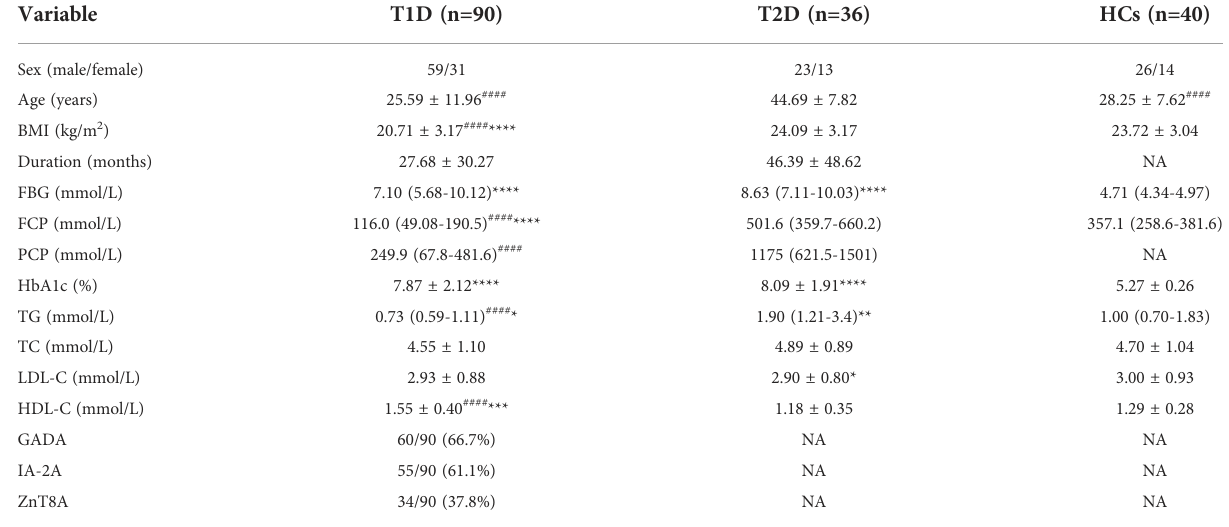
TABLE 1 Clinical characteristics of all the study participants.